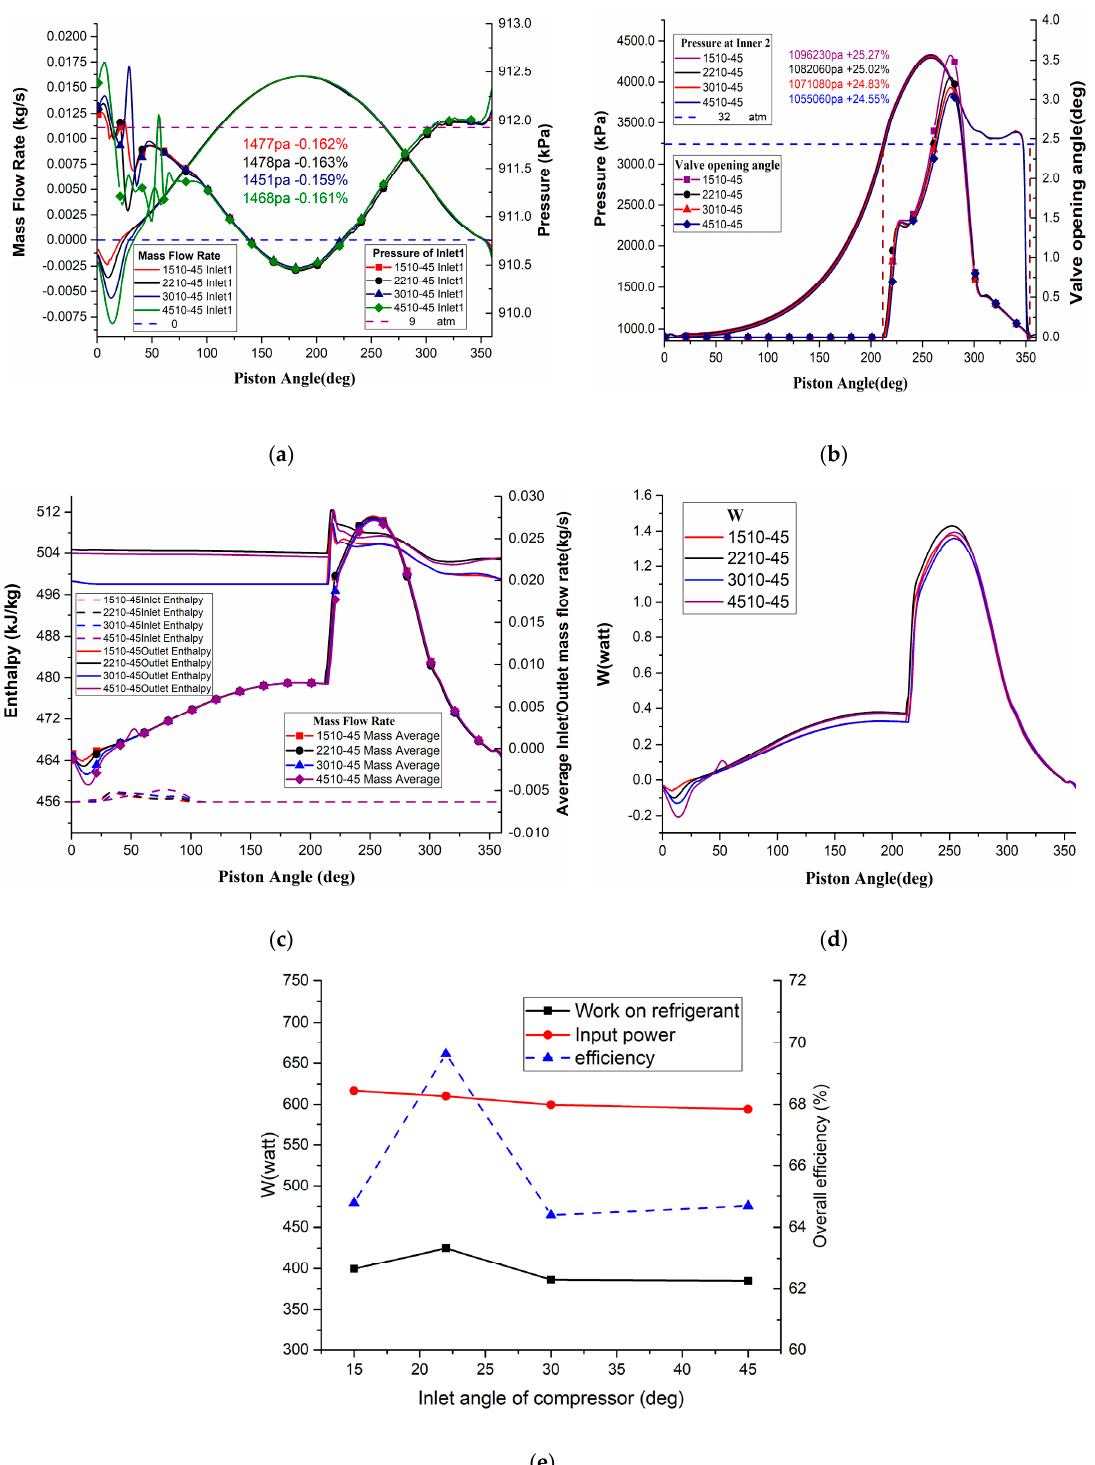
Figure 14. Physical properties arising from different inlet angles, 𝛼 = 15 ˚ to 45 ˚ : ( a ) mass flow rate and pressure at Inlet 1, ( b ) pressure of compression chamber at Inner 2 and opening angle of reed valve, ( c ) enthalpy at inlet/outlet and average mass flow rate, ( d ) instantaneous rate of work done on the refrigerant, and ( e ) mean work done on the refrigerant, input power and overall efficiency.